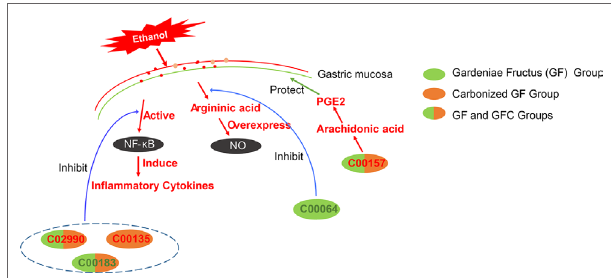
FIGURE 8 | The putative gastroprotective mechanism of GF and GFC in rats with ethanol-induced gastric lesions. GF and GFC reduce the expression of NO and release of inflammatory cytokines, and induce prostaglandin E2 (PGE2) to ameliorate gastric mucosa lesions in rats. C02990 and C00157 (red text) refer to L-palmitoylcarnitine and phosphatidylcholines which were significantly upregulated in the GF and GFC groups. C00183 (green text) refers to L-valine which was significantly downregulated in the GF and GFC groups. C00064 (green text) refers to L-glutamine which was down-regulated in the GF group. C00135 (red text) refers to L-histidine which was markedly upregulated in the GFC